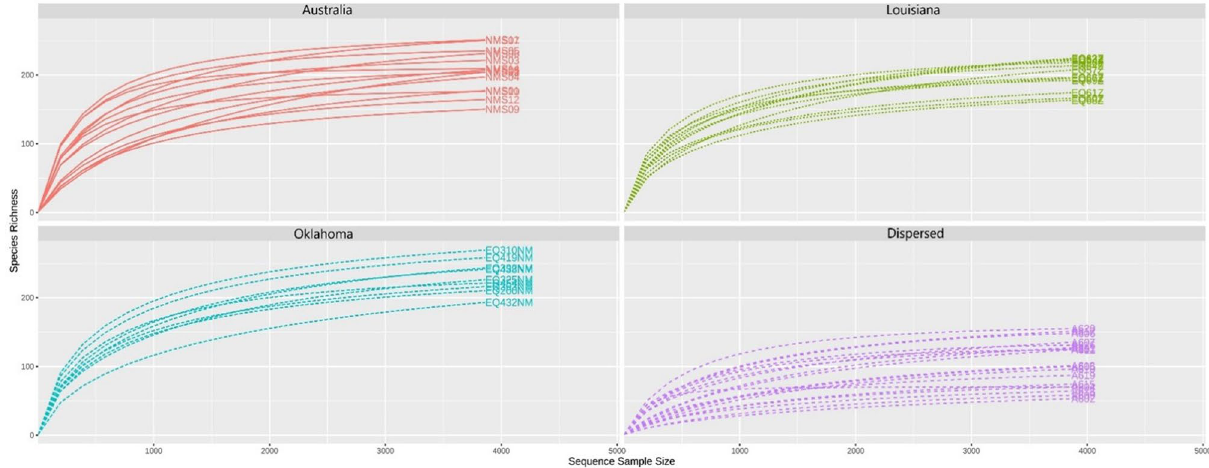
Figure 1. Rarefaction curves for all samples used for this study. Each curve is color coded based on the group it belongs to; Australia (n = 14), Oklahoma (n = 9), Louisiana (n = 12) and Dispersed (n =